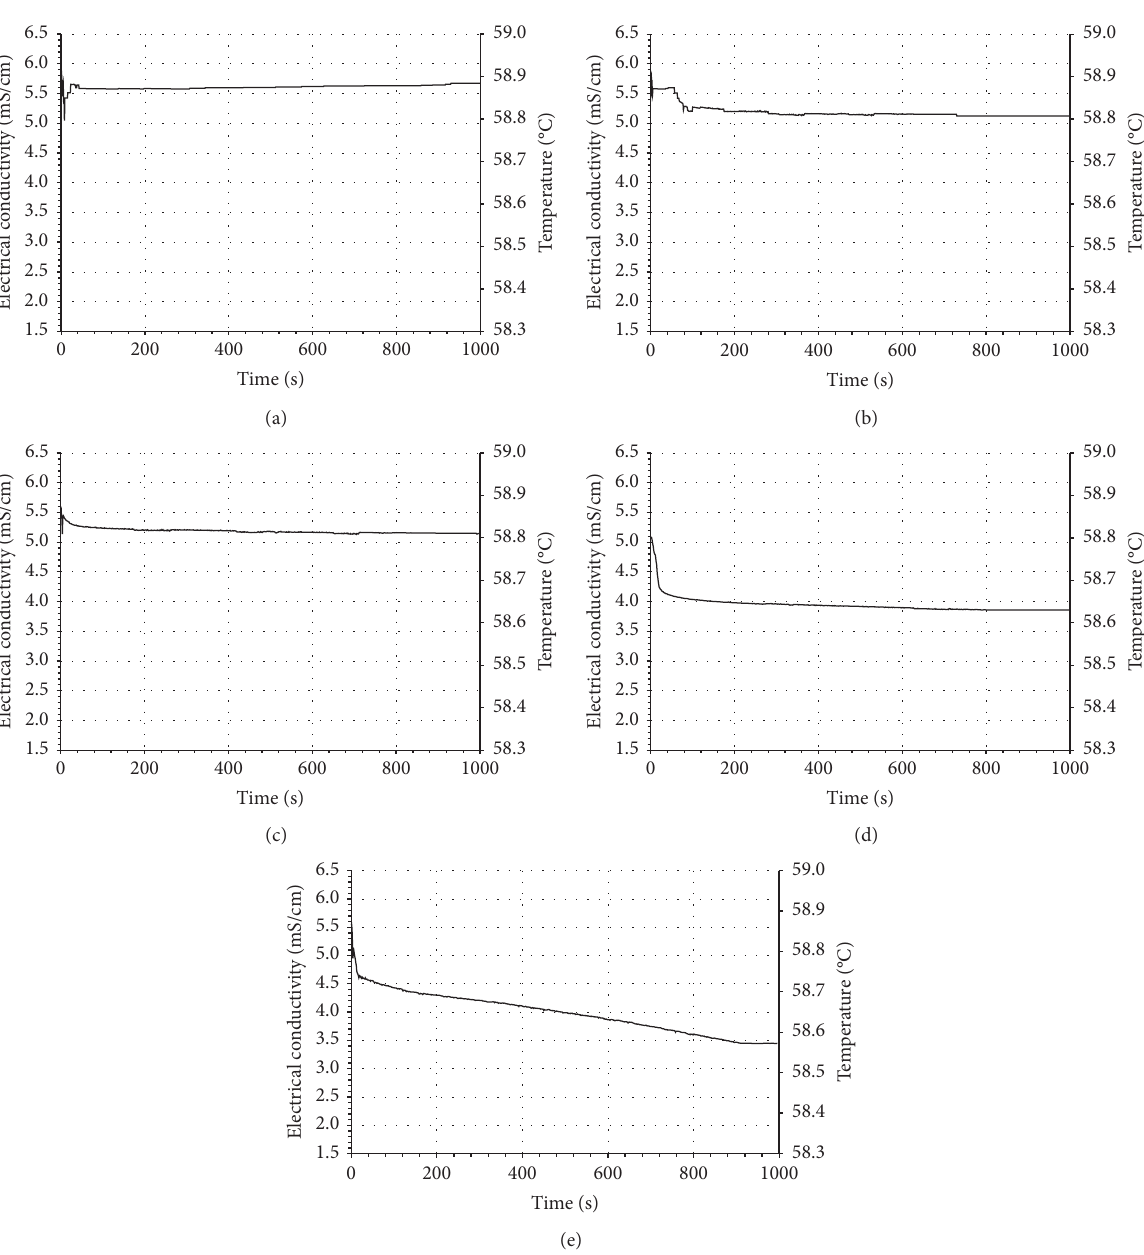
Table 5: Summary of electrical conductivity and performance indices.